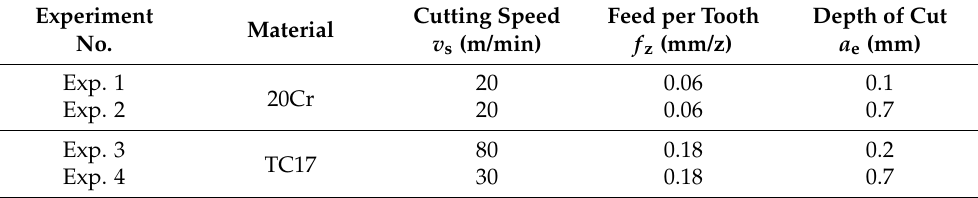
Table 5. Experimental parameters.